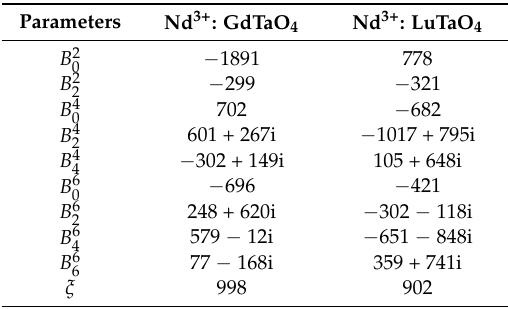
Table 8. Parameters of Nd 3+ in GdTaO 4 and LuTaO 4 .